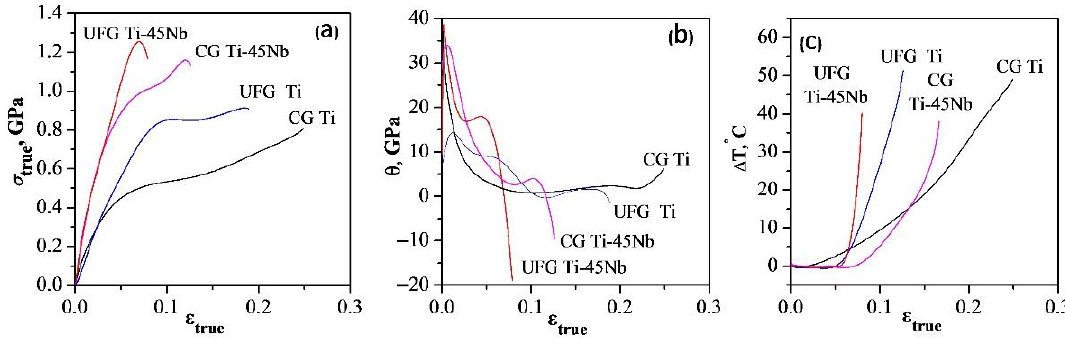
Figure 2. True deformation σ true ( ε true ) curves ( a ), strain hardening coefficient θ ( ε true ) = d σ true /d ε true ( b ) and temperature curves ∆ T ( ε true ) ( c ).